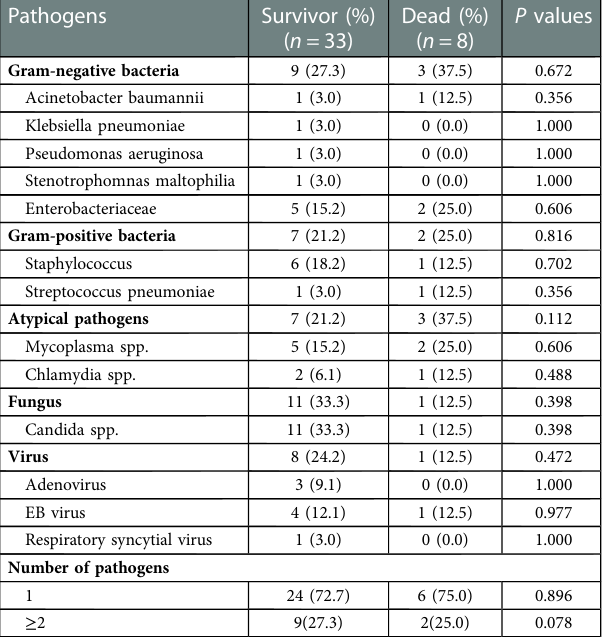
TABLE 3 Microbiological fi ndings in blood culture of children with severe CAP in PICUs ( n =41). Pathogens